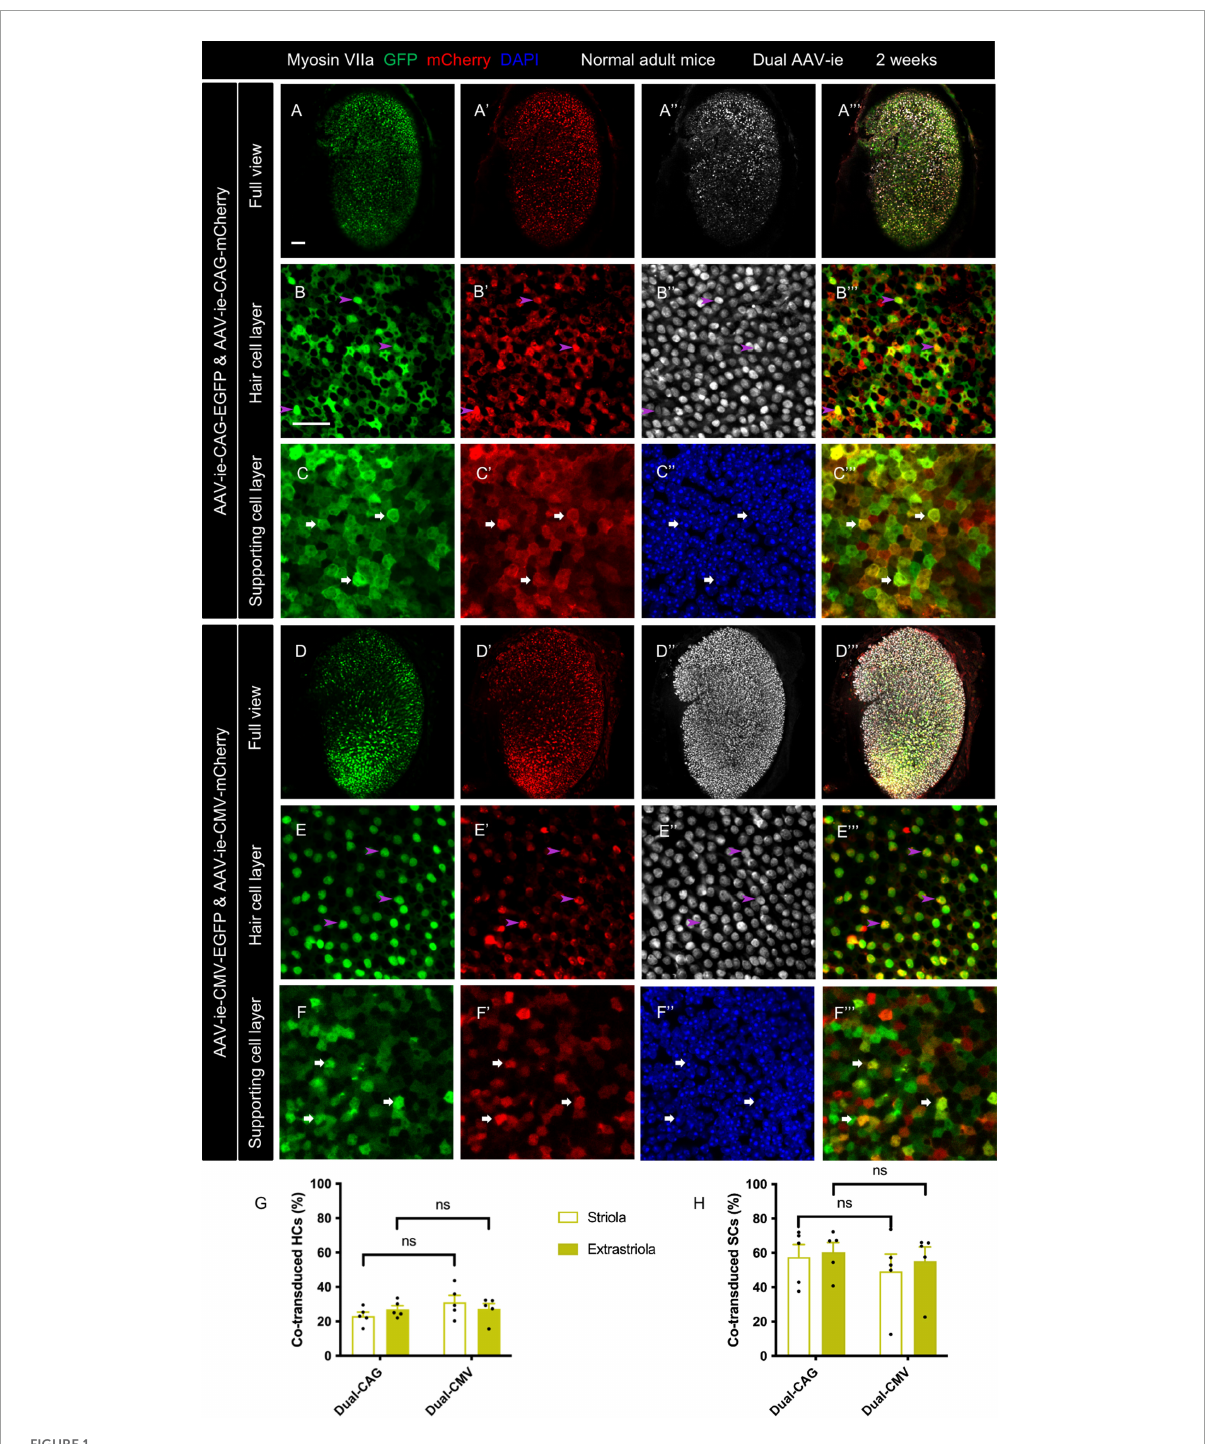
FIGURE1 Co-transduction of dual-AAV-ie vectors in the normal adult mouse utricle. Dual AAV-ie-CAG vectors (AAV-ie-CAG-EGFP and AAV-ie-CAG-mCherry) or dual AAV-ie-CMV vectors (AAV-ie-CMV-EGFP and AAV-ie-CMV-mCherry) were inoculated into the inner ear of adult mice. Utricles were harvested 2 weeks after the surgery. (A–C”’) Low- (A–A”’) and high- (B–C”’) magnification images show extensive co-expression of GFP and mCherry in both HCs (arrowheads in B–B”’ ; representative images of the extrastriolar region) and SCs (arrows in C–C”’ ; representative images of the striolar region) after transduction by dual AAV-ie-CAG vectors. (D–F”’) Abundant HCs (arrowheads in E–E”’ ; representative images of the extrastriolar region) and SCs (arrows in F–F”’ ; representative images of the extrastriolar region) express both GFP and mCherry after transduction by dual-AAV-ie-CMV vectors. Scale bars, 50 µ m in A for (A–A”’) and (D–D”’) ; 20 µ m in B for the remaining images. (G,H) Quantitative analysis showing that dual-AAV-ie-CAG and dual-AAV-ie-CMV vectors achieve comparable co-transduction rates in HCs (G) and SCs (H) . Data are mean ± SEM. P- values were calculated by Student’s t -test. “ns”, not